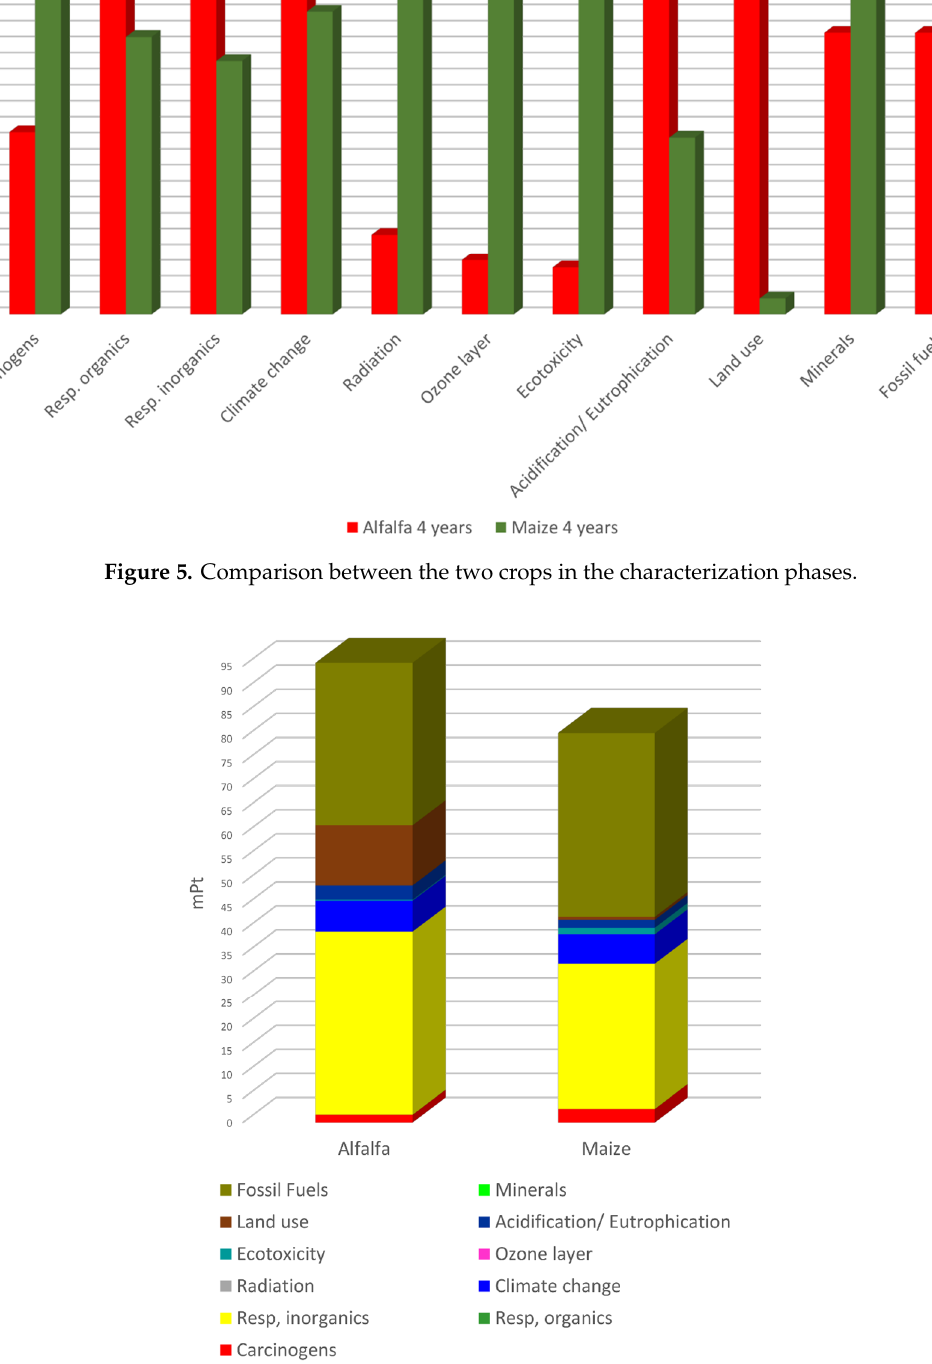
Figure 6. Comparison between the combined impacts in milli-Points (mPt) two crops in the single point phases.